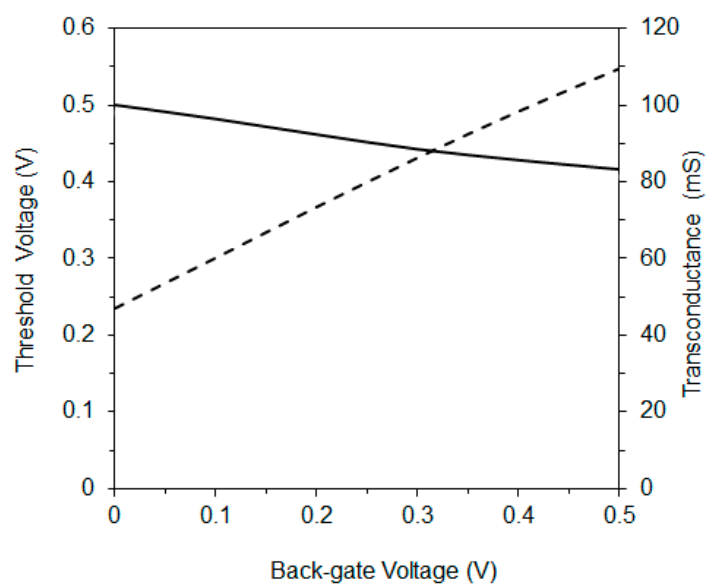
Figure 4. Simulated threshold voltage and transconductance versus back-gate voltage variations of the M 1 at 0.5-V bias voltage.